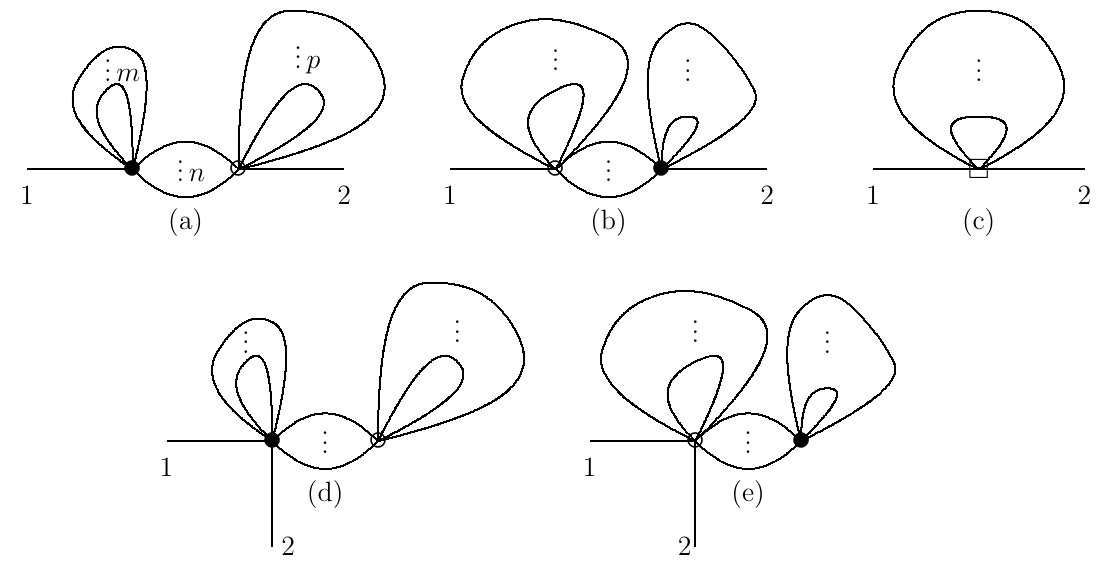
Figure 1 . Feynman diagram representation of